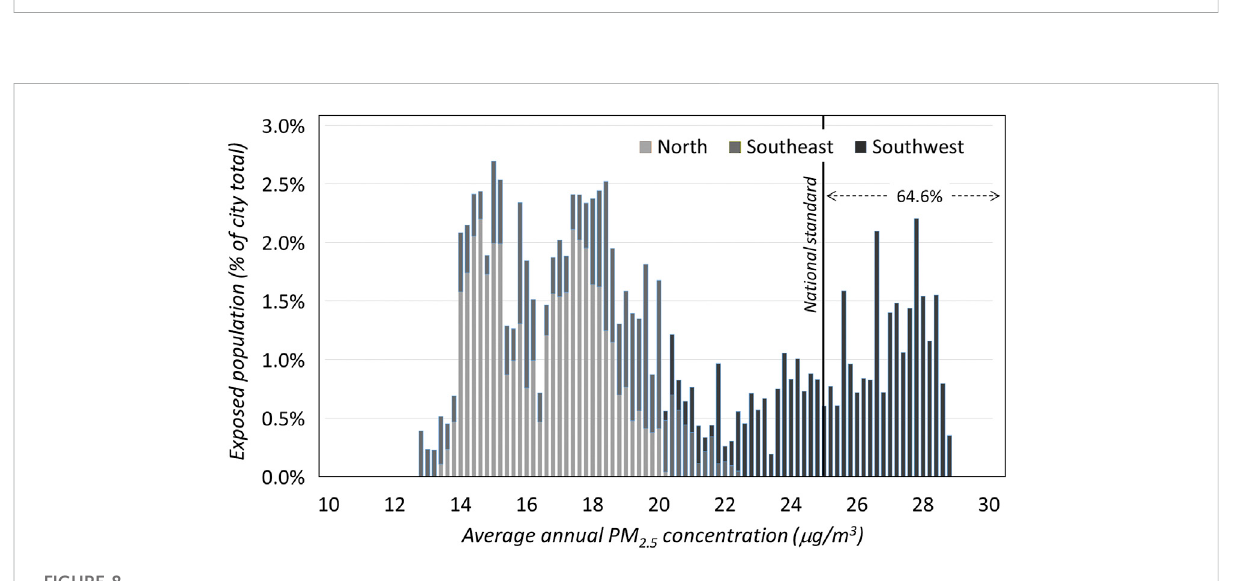
FIGURE 8 Detailed contribution of each cluster to the PM 2.5 air pollution